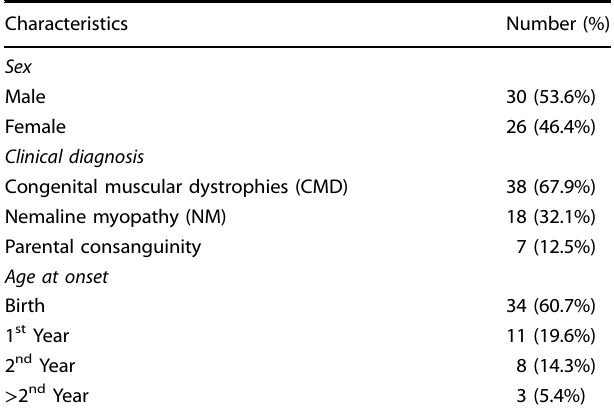
Table 1. Demographic characteristics of the